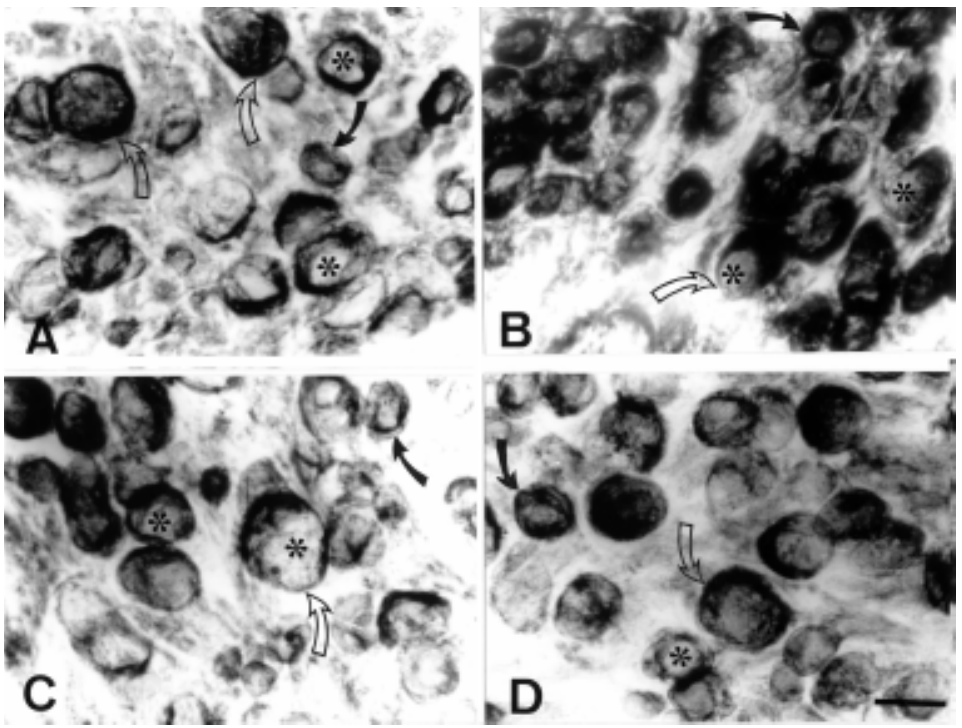
Figure 1 - NADPH-d activity in medium (open arrows) and small (filled arrows) neurons of the turtle dorsal root ganglia after transection of the sciatic nerve. Material from untreated turtles (A) and material obtained 15 (B), 30 (C) and 90 days (D) after pe- ripheral axotomy. Asterisks indi- cate negative activity in the nucleus. Scale bar = 150